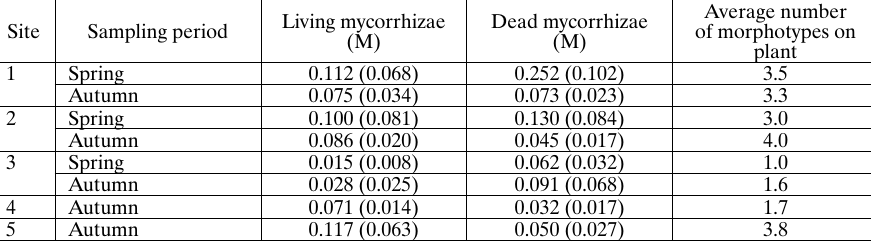
Quantity of living and dead mycorrhizae (as M values with corresponding standard devia tions in brackets) and average numbers of morphotypes per plant on study